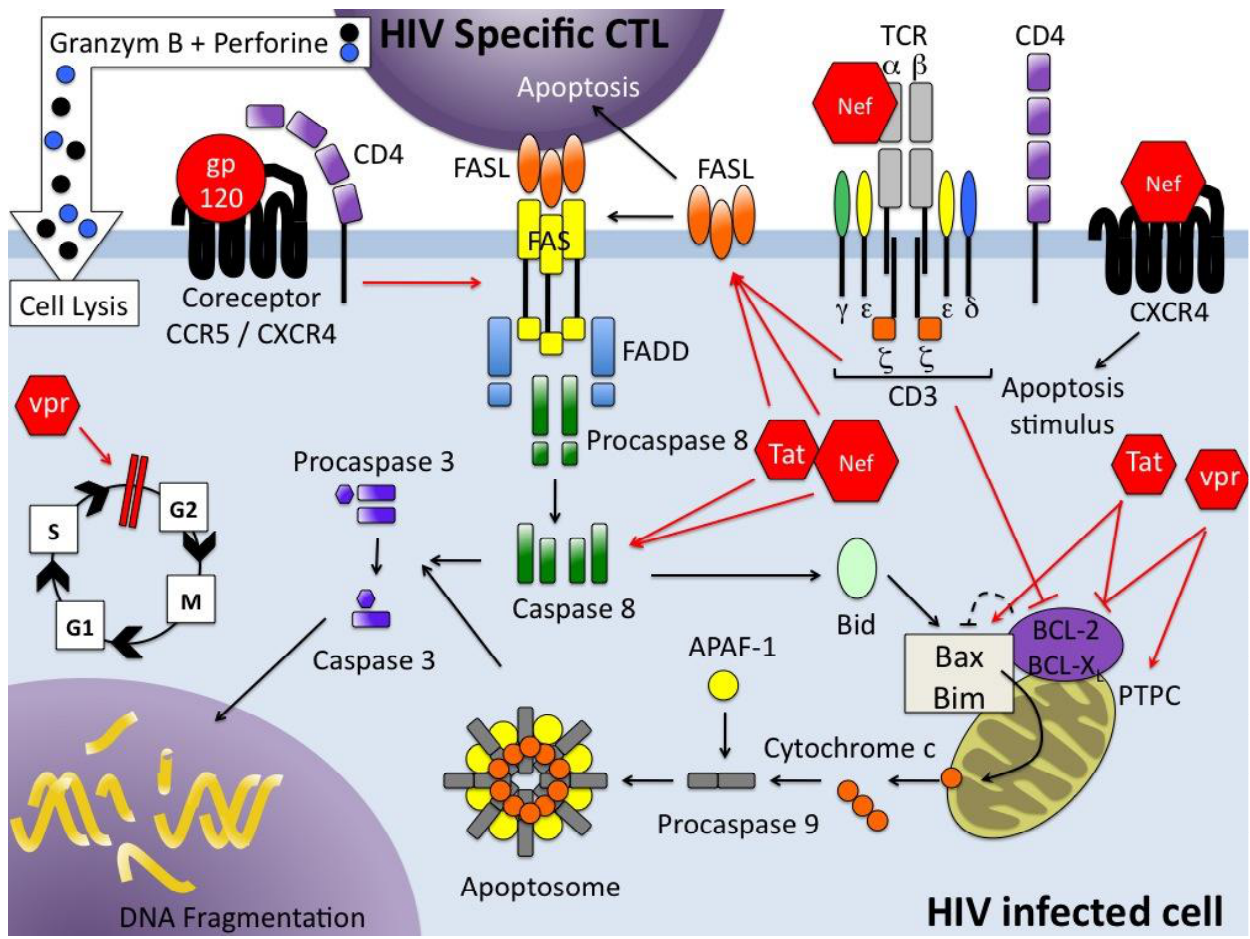
Figure 1 Fevrier et al .,